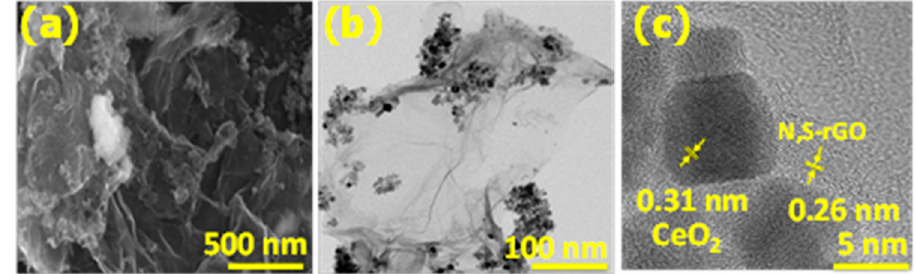
Figure 3 . ( a ) SEM, ( b ) TEM and ( c ) HRTEM images of 3% Co–CeO 2 /N, S–rGO. Figure 3. ( a ) SEM, ( b ) TEM and ( c ) HRTEM images of 3% Co–CeO